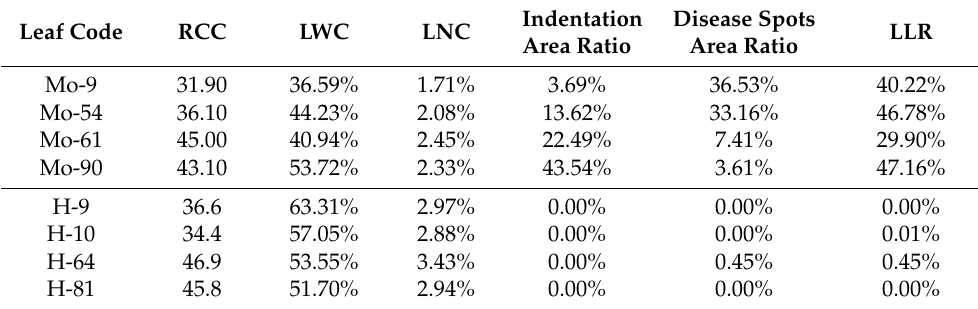
Table 5. The measured factors of selected